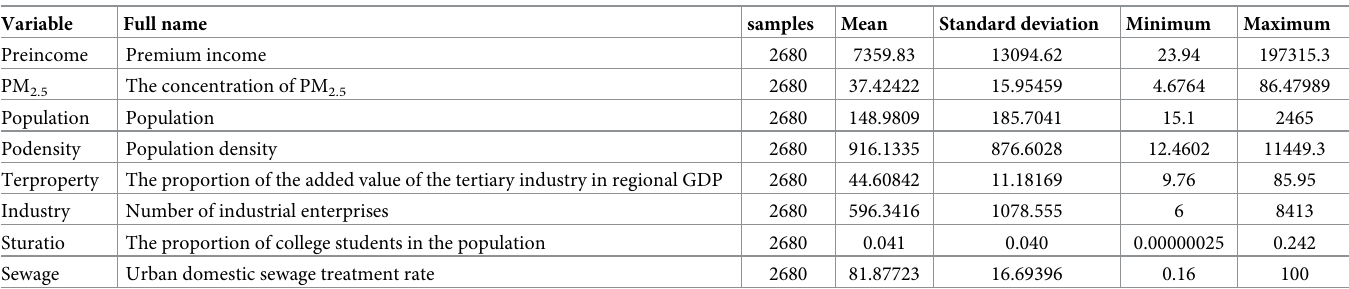
Table 1. Descriptive statistics of main variables.